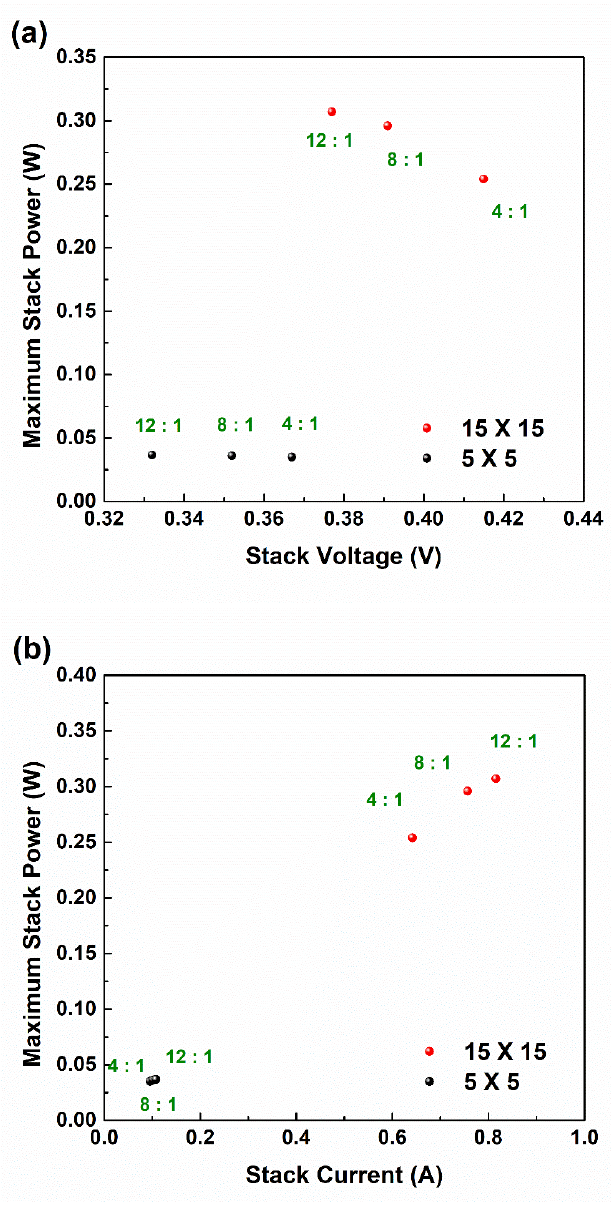
Figure 3. Relationship between maximum power and ( a ) stack voltage, and ( b ) stack current, according to PIEM composition and RED stack